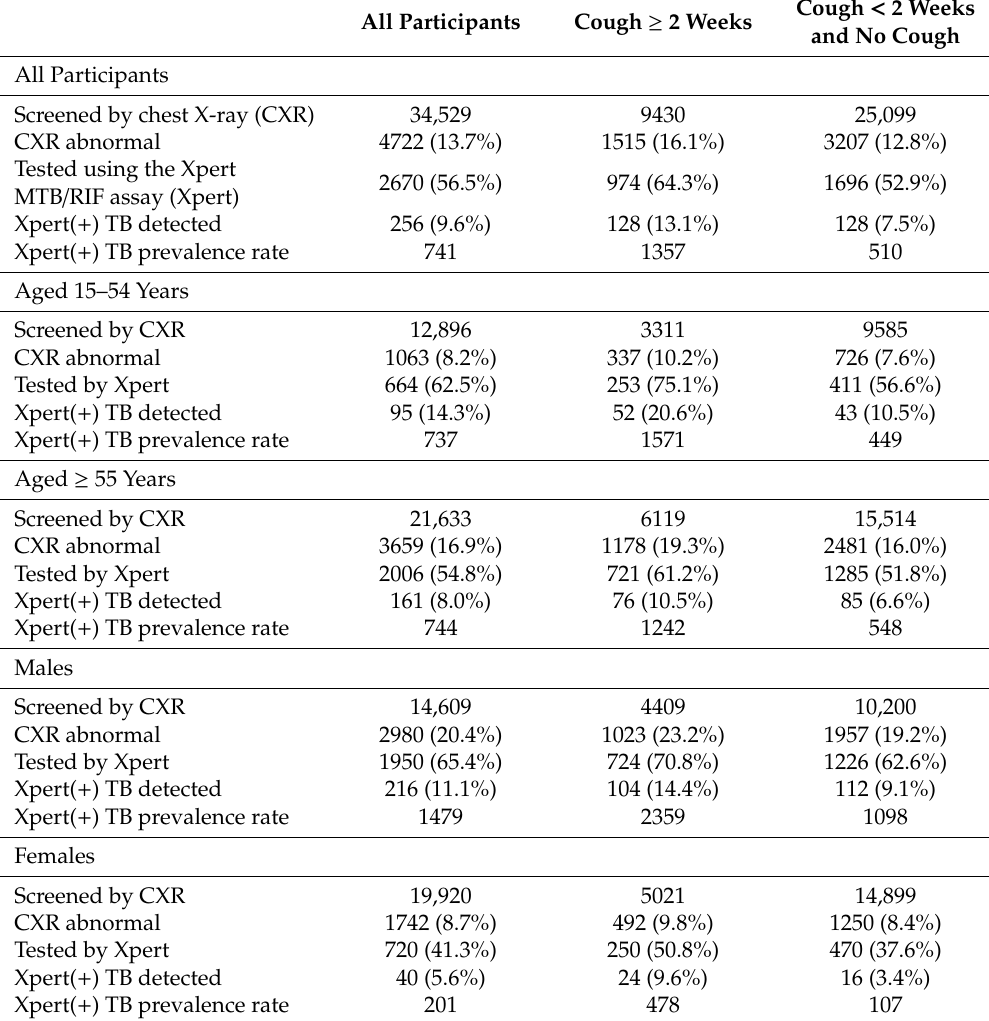
Table 1. Yields of tuberculosis (TB) screening by cough status, age group and